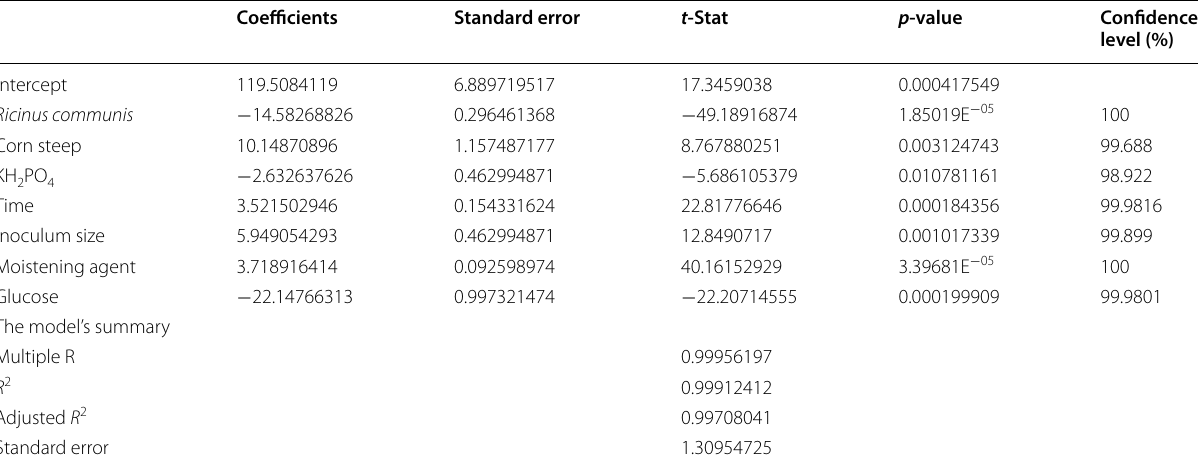
Table 3 A statistical analysis of the Plackett‑Burman design shows coefficient values, effect, t ‑ and P ‑values for each variable on the xylanase study